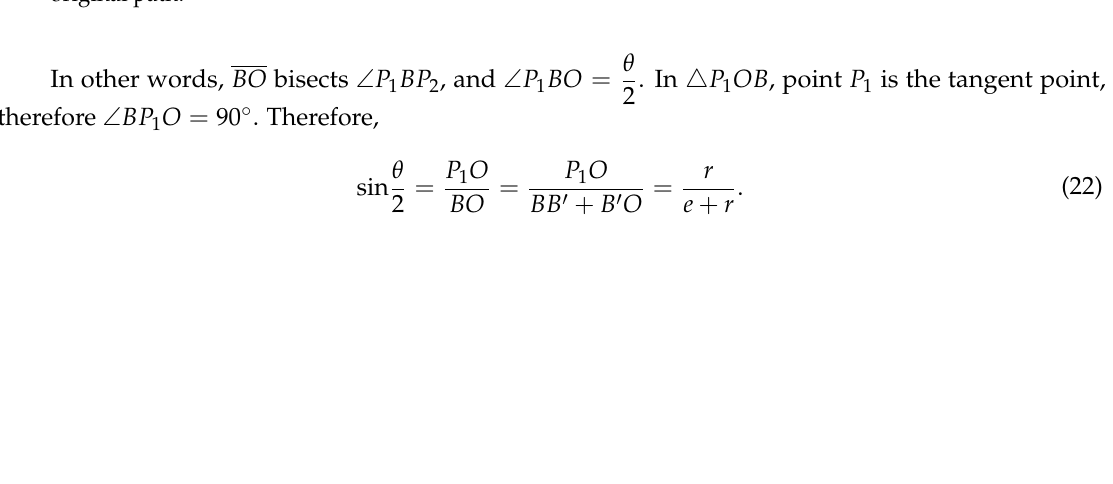
Figure 5. Calculation of robot’s proximity from obstacles on the smooth path compared to the original